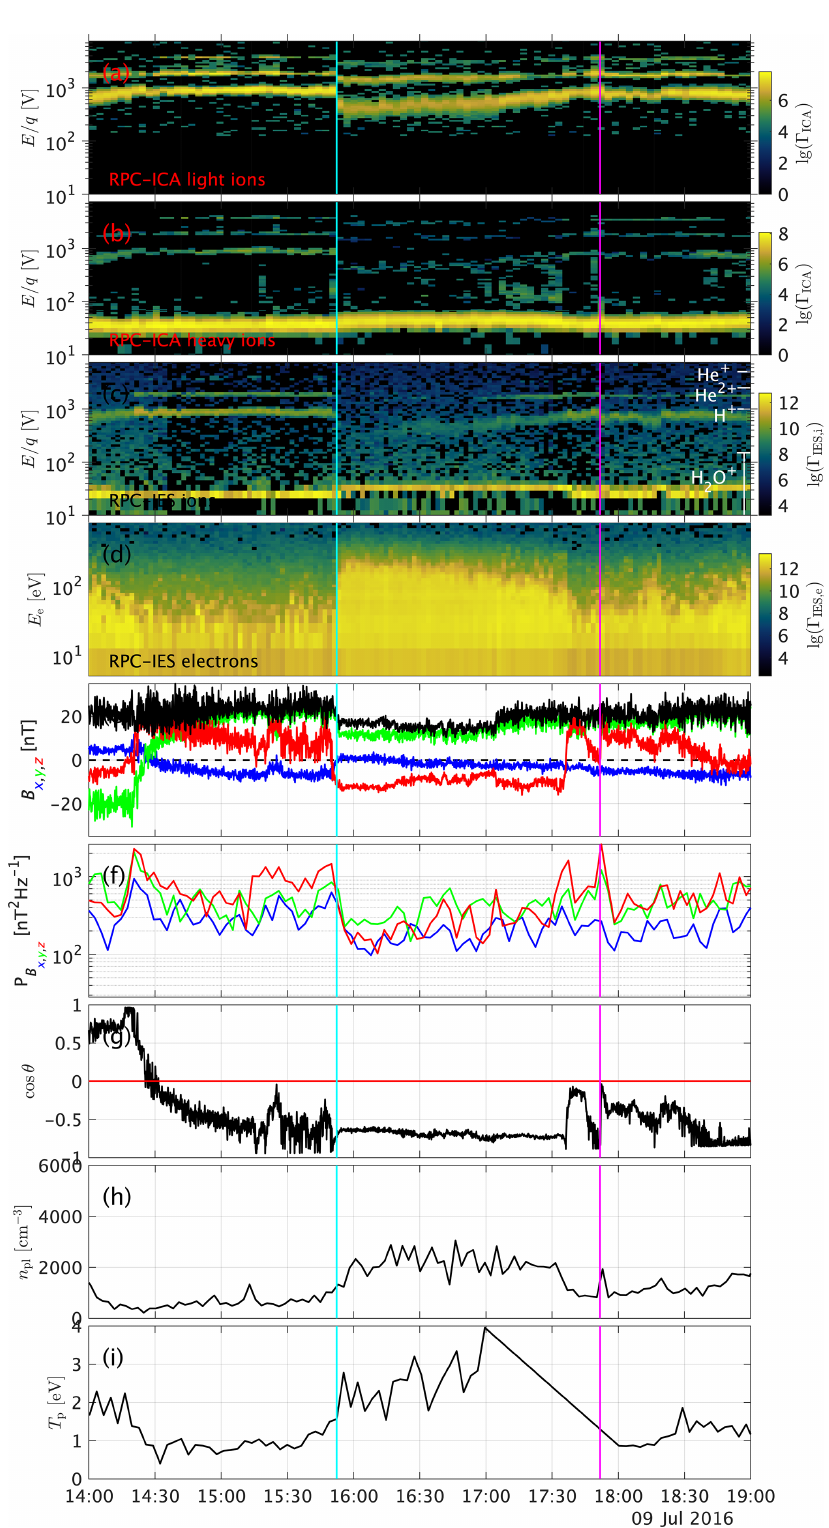
Figure 1. Observations of the event on 9 July 2016. From top to bottom, (a) ICA solar wind ions, (b) ICA heavy ions, (c) IES ions, (d) IES electrons, (e) magnetic field in CSEQ coordinates, (f) magnetic power spectral density in the frequency range between 2 and 15mHz, (g) angle between spacecraft position and convective electric field, (h) plasma density from LAP, and (i) 1D proton temperature from